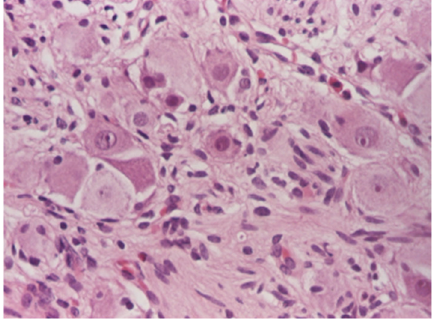
Figure 9. Mature ganglion cells, HE × 200.